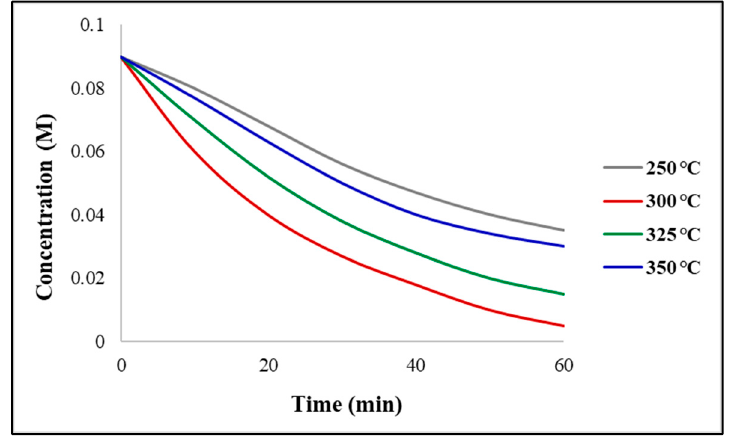
Figure 6. Inlet concentration time plots at varying temperatures with catalyst = Ni/ZrO 2 . Reaction conditions: pressure = 30 bar, H 2 /oil ratio = 1000, inlet liquid flow = 0.1 mL/min and t = 60 min.